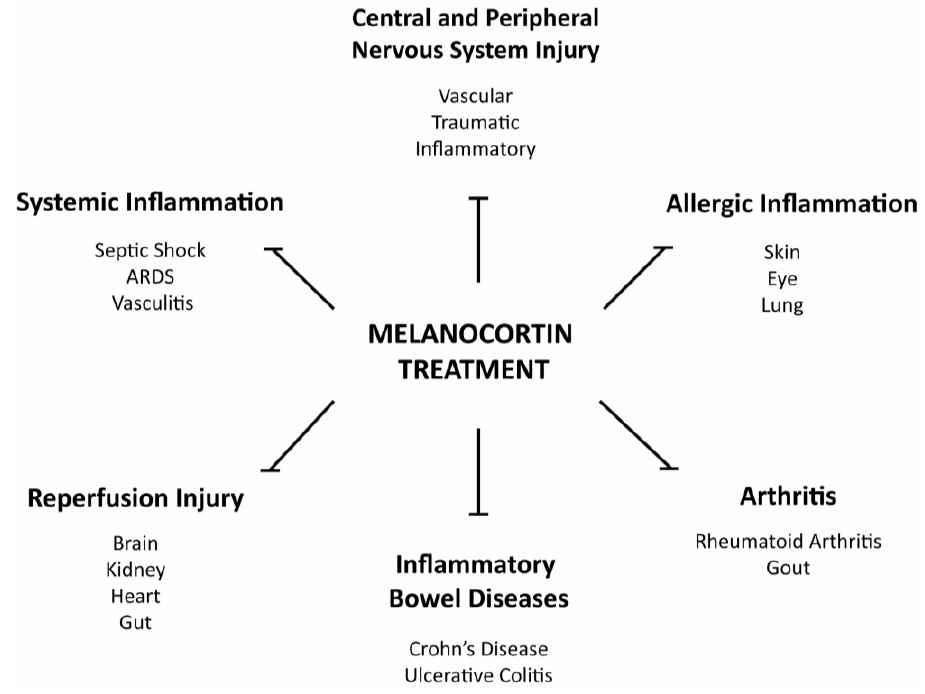
FIGURE 1. Beneficial effects of melanocortin treatment are well documented in preclinical models of inflammatory